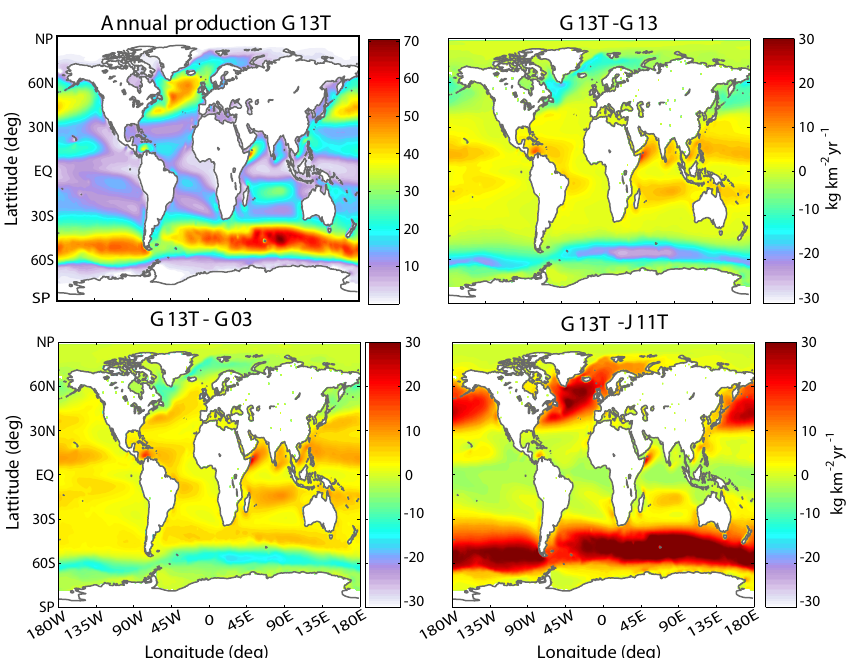
Fig. 7. Top left: annual global production for the new source function G13T. Top right: the difference in global annual production when taking into account the temperature influence (G13T) and when ignoring temperature influence (G13) for the new source function. Bottom left: the difference between G13T and G03. Bottom right: the difference between G13T and J11T. For acronyms in the legend, see Table